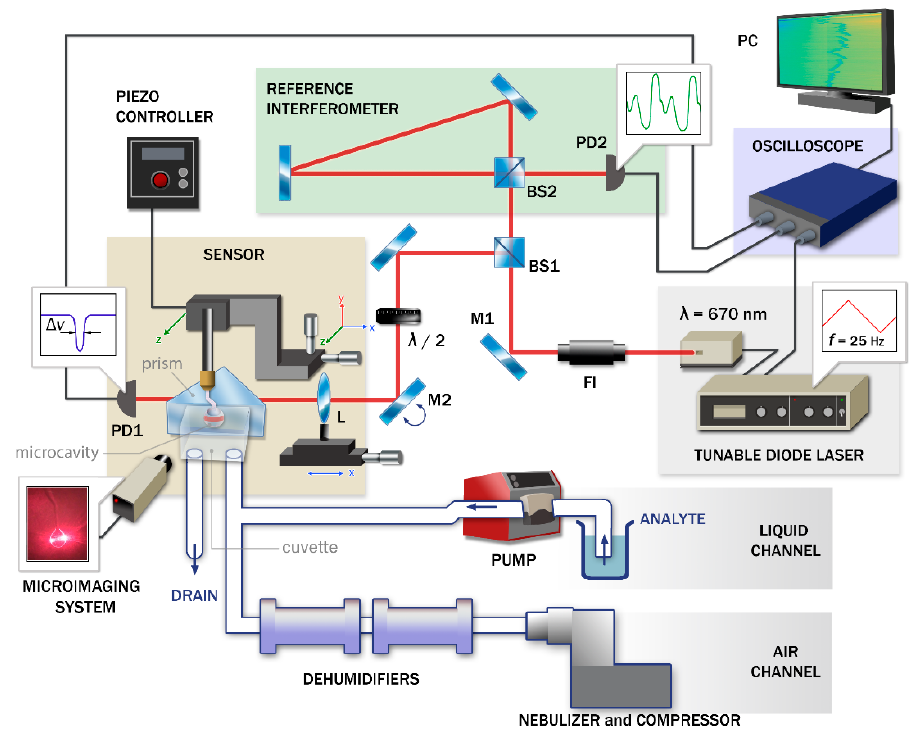
Figure 3. A scheme of a two-channel measurement system for liquid and gas media: PD1, PD2—photodetector; BS1, BS2—beam splitter; L—lens is mounted on a micrometric slide; M2—kinematic mounts for round optics with mirror; FI—free-space isolator; λ / 2—half-wave plate.